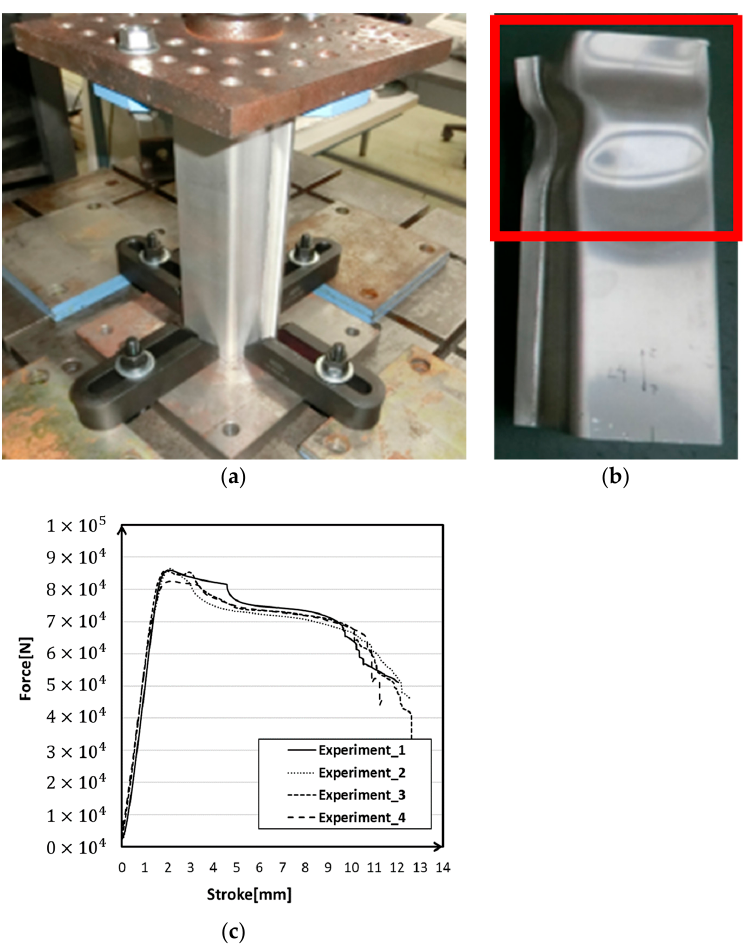
Figure 4. Experiment device and results: ( a ) loading device; ( b ) deformed crash box; ( c ) reaction force verse stroke curves.